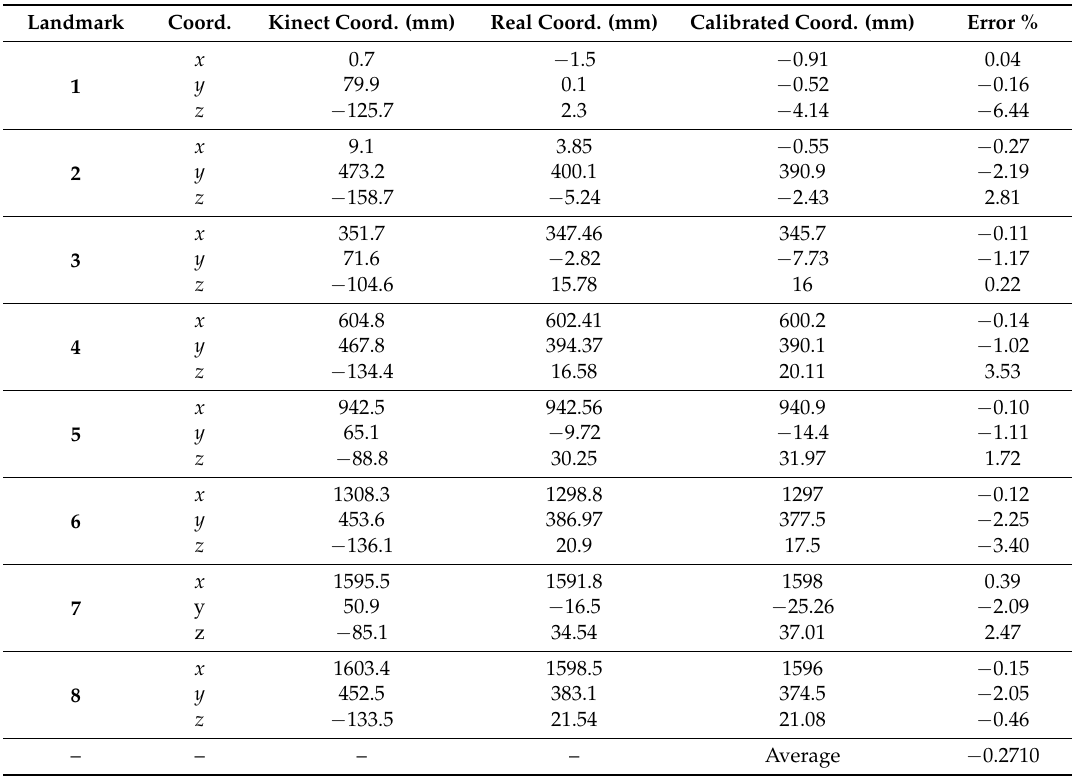
Table 2. Results table of the point cloud alignment.